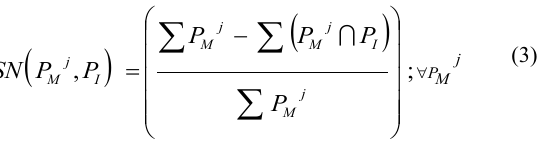
Figure 5. Randomly sampled putative matches in θ-ρ space